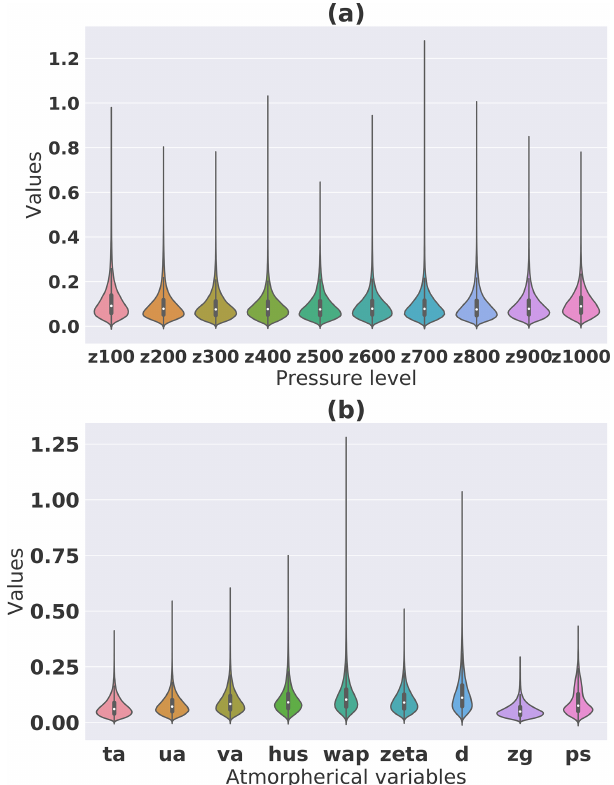
Figure 18. Wasserstein distance between 5000 datasets and gener- ated samples on each pixel grouped by pressure height (a) or vari- ables (b)